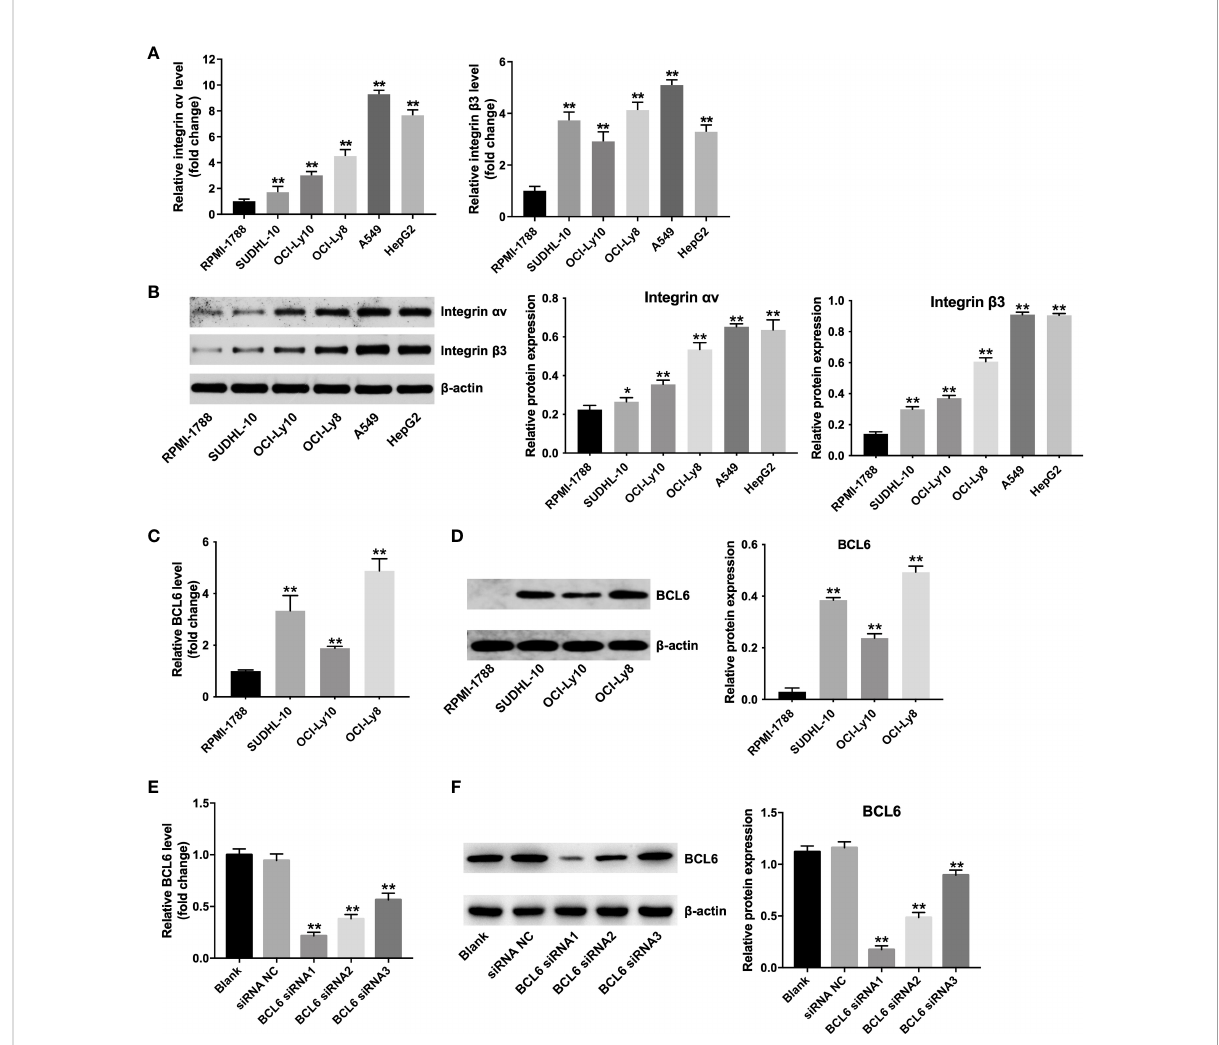
FIGURE 1 Predominant a v b 3 integrin expression in DLBCL cells. (A) RT-qPCR and (B) western blot analysis of a v integrin and b 3 integrin levels in RPMI- 1788, SUDHL-10, OCI-Ly10, OCI-Ly8, A549 and HepG2 cells. *P < 0.05, **P < 0.01 vs. RPMI-1888 group. (C) RT-qPCR and (D) western blot analysis of BCL6 levels in RPMI-1788, SUDHL-10, OCI-Ly10 and OCI-Ly8 cells. **P < 0.01 vs. RPMI-1888 group. (E) RT-qPCR and (F) western blot analysis of BCL6 levels in OCI-Ly8 cells transfected with BCL6 siRNA1, BCL6 siRNA2, or BCL6 siRNA3. **P < 0.01 vs. siRNA NC group. All tests were repeated in